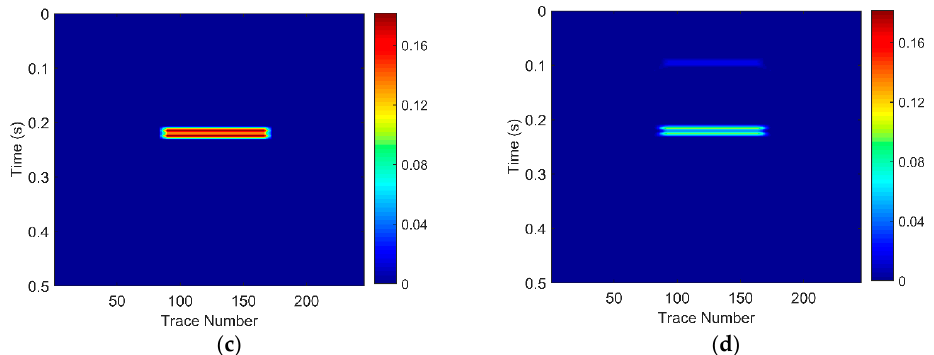
Figure 4. For Geological Model 2: ( a ) the gas-bearing layer is 20 m; ( b ) the seismic response; ( c ) the low frequency section; and ( d ) the high frequency section.